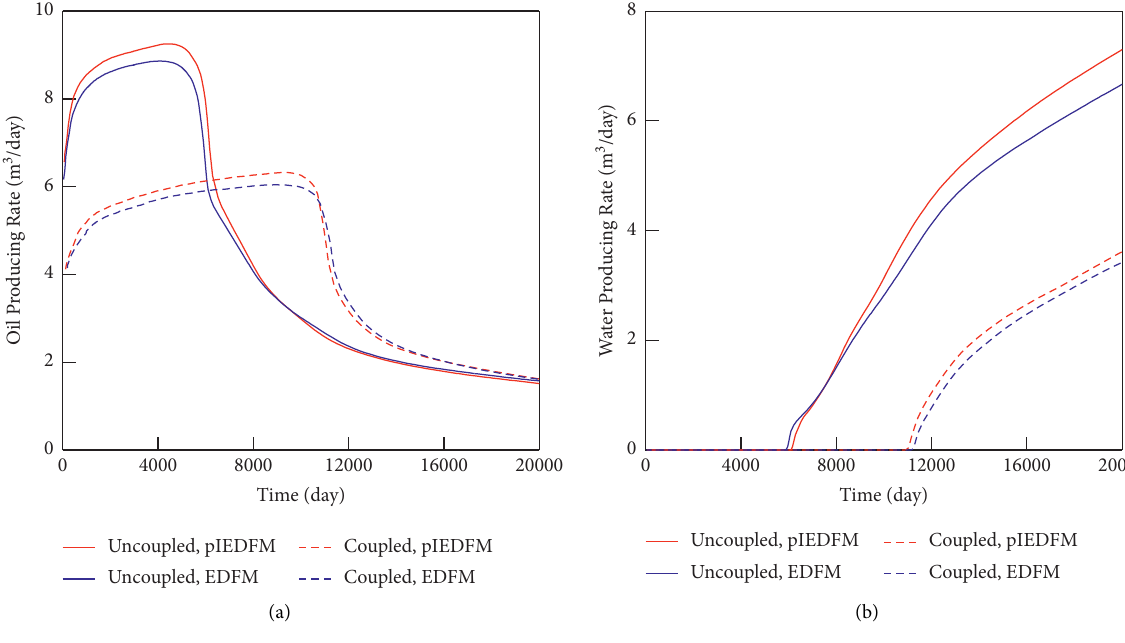
Figure 24: (a) Oil and (b) water producing rate histories.